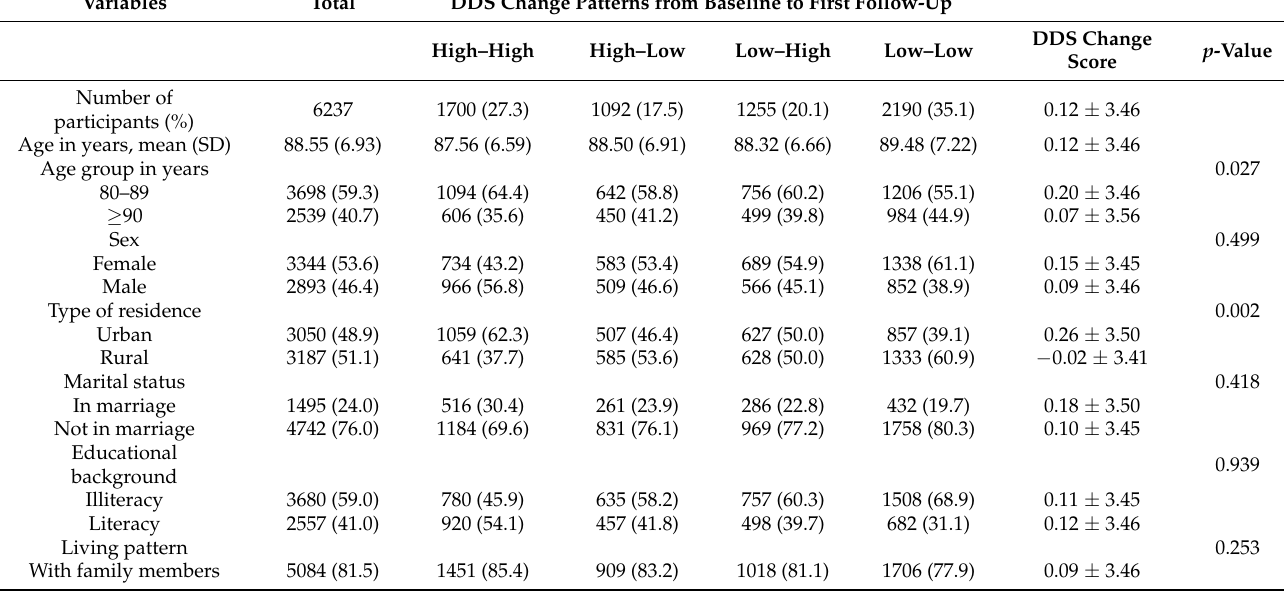
Table 1. Characteristics of the 6237 participants at the